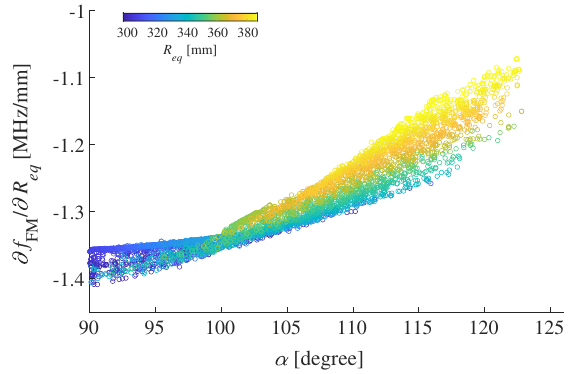
FIG. 3. The local sensitivity of f with respect to R eq plotted FM versus the wall slope angle α . Around 5 ’ 000 samples of cavities with different values of R eq , L , A , B , a , b and R i are studied. The frequency of each sample is tuned to 400.79 MHz. The local sensitivity is calculated using the forward difference method with the step h ¼ 1 mm. Generally, a higher wall slope angle yields a less sensitive f against changes in R eq . FM